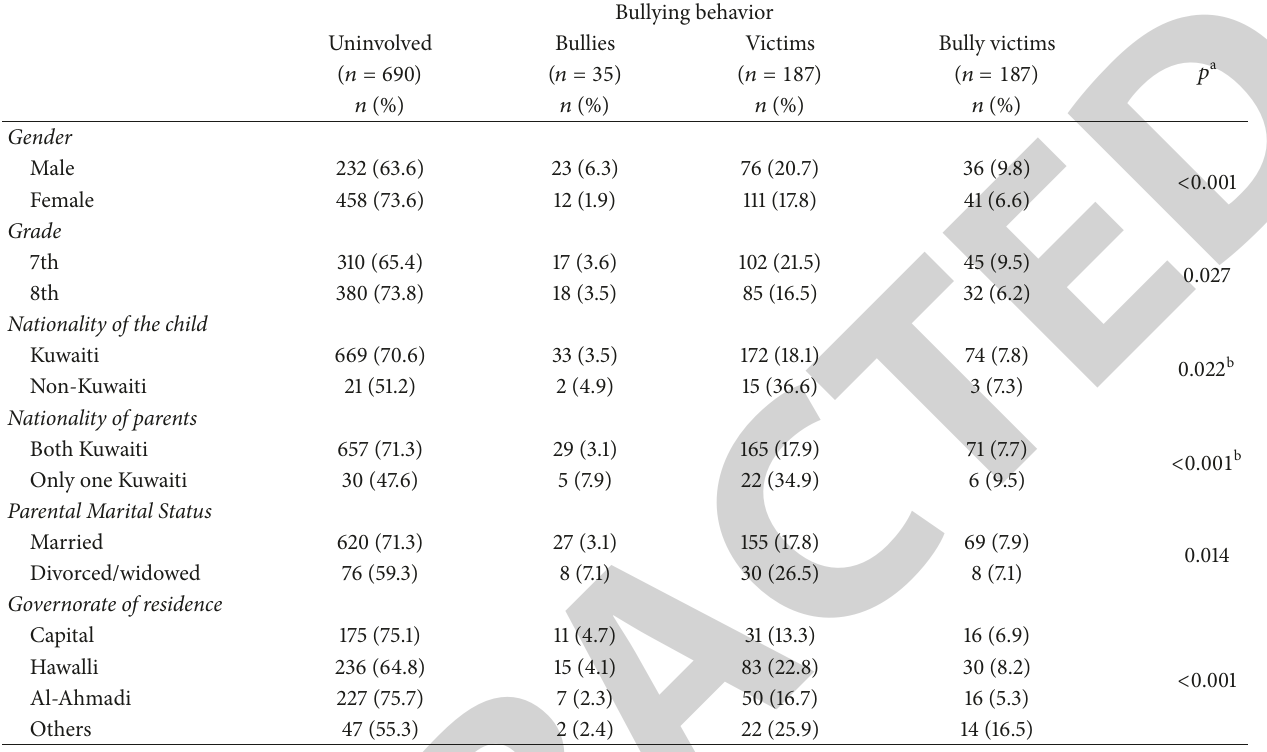
Bullying behavior Uninvolved Bullies Victims Bully